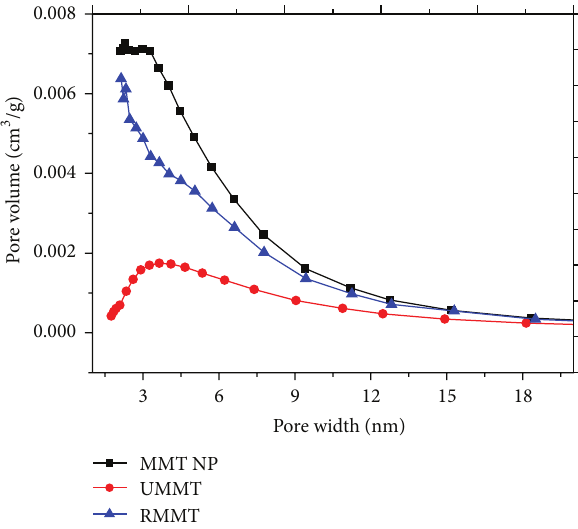
Figure 8: BJH pore size distributions of MMT NP, UMMT, and